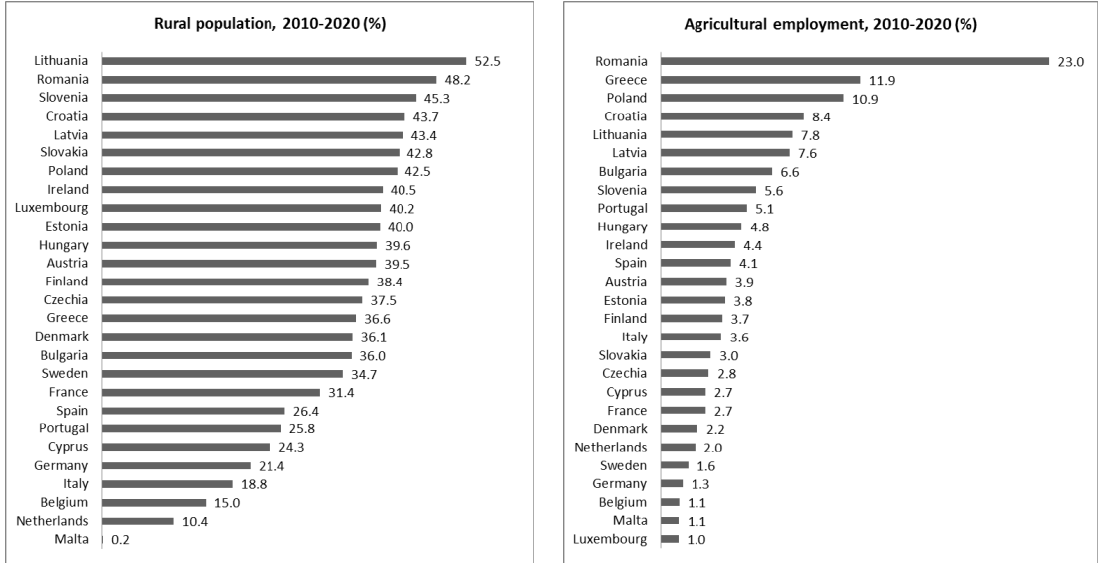
Figure 3. Rural specificity of the EU member states. Source: own research based on Eurostat data